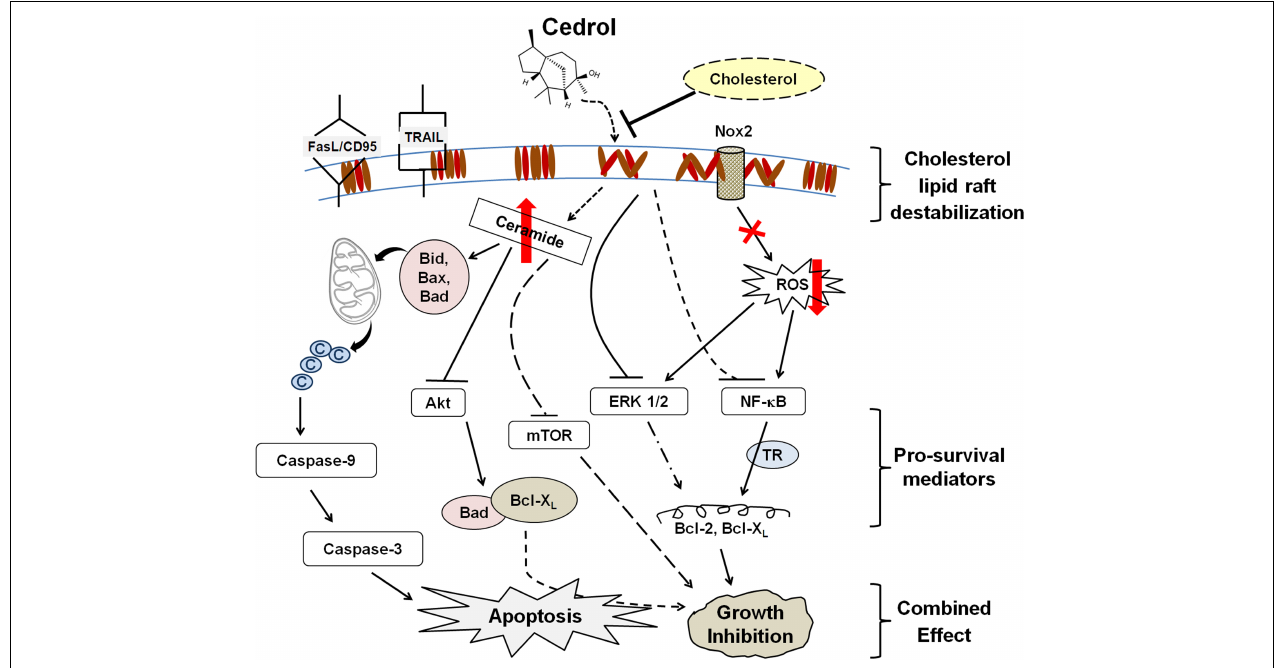
FIGURE 7 | Schematic sumamry of the molecular signaling triggered by cedrol. Cedrol depletes cholesterol from membrane lipid raft and leads to modulation of various cellular biochemical signaling events within cell. ©, cytochrome c; TR, transcriptional